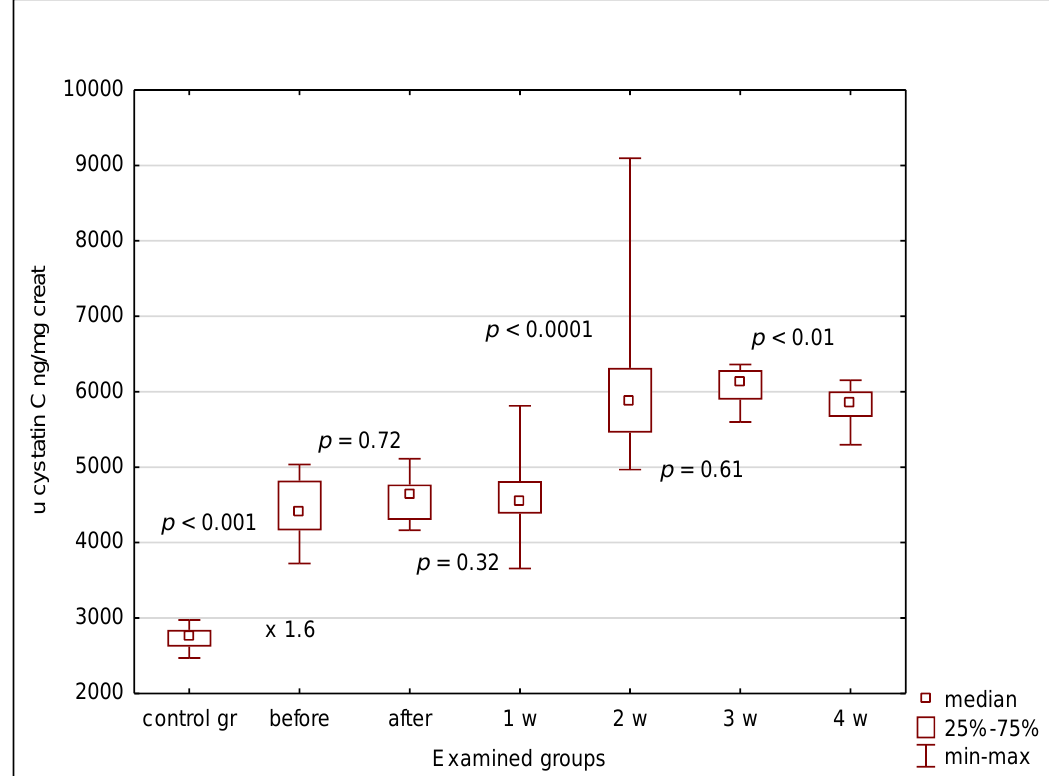
Figure 4. Urinary cystatin C values in examined groups. before—before alloHSCT; after—24 h after